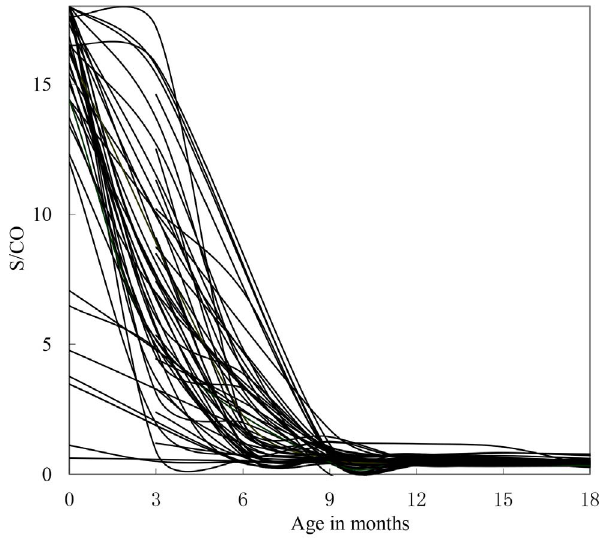
Figure 2. Anti-HIV S/CO values of infected infants at individual level. Black lines indicate the initial decrease and subsequent increase in S/CO; red lines indicate the initial increase and subsequent decrease in S/CO; blue lines indicate infants who died of HIV infection; and dotted lines indicate other infants. The figure was derived from 85 DBSs of 24 infected infants. The arrow indicates